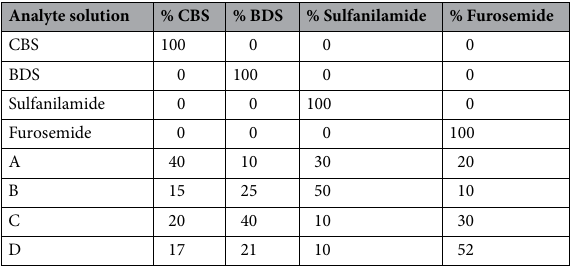
Table 1. Molar composition of the analyte solutions used in this